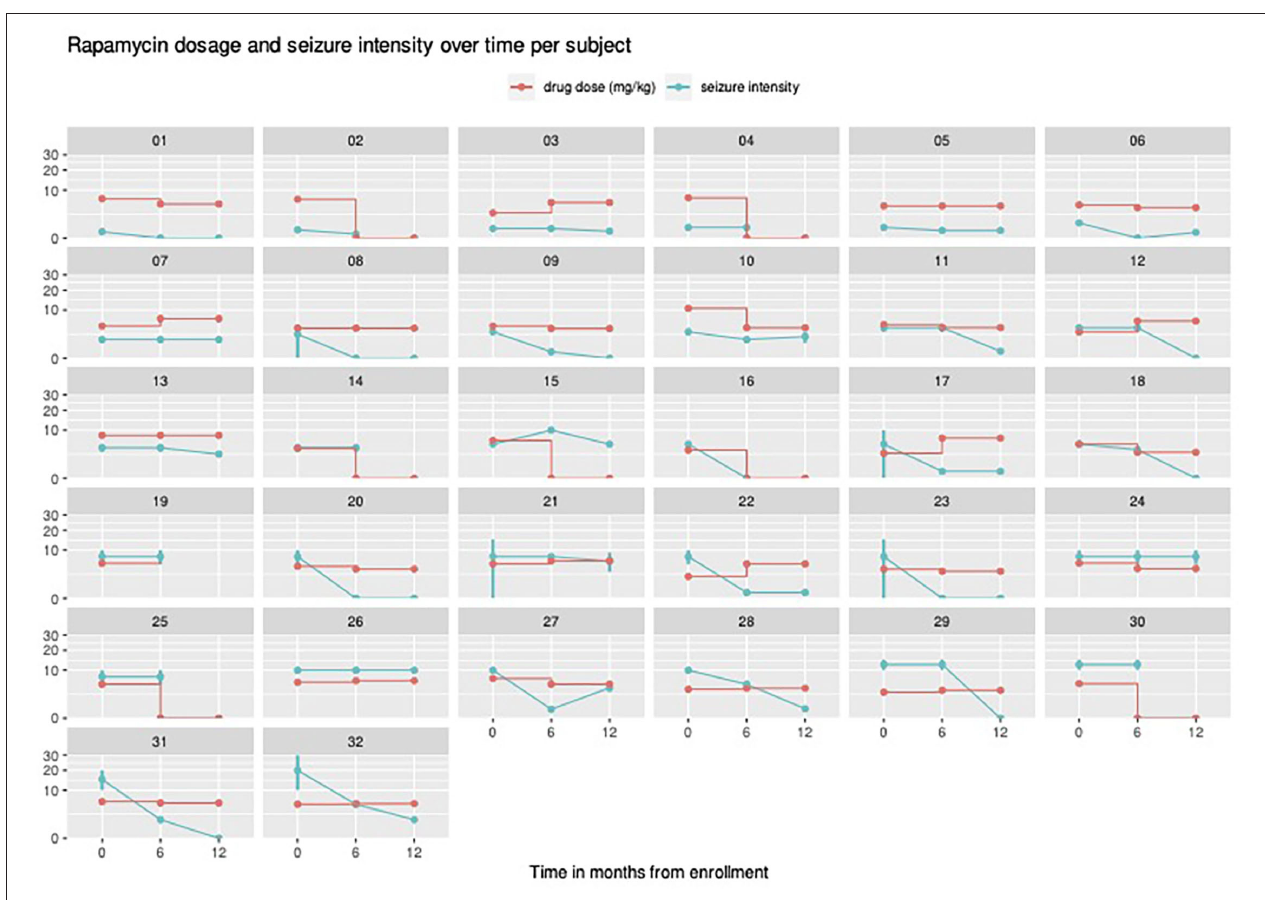
FIGURE 2 | Individual therapy regimes (rapamycin dosage) visualized for all patients across the study together with observed seizure intensity. If seizure intensity was described by the caregivers as interval it was visualized as a vertical bar. The vertical axis shows the serum rapamycin concentration ranges, marked for individual patients with red lines. Seizure frequency was quantified by the course of the green lines—decrease with lower frequency and increase with higher frequency of seizures. “Seizure intensity” was defined as seizure number per